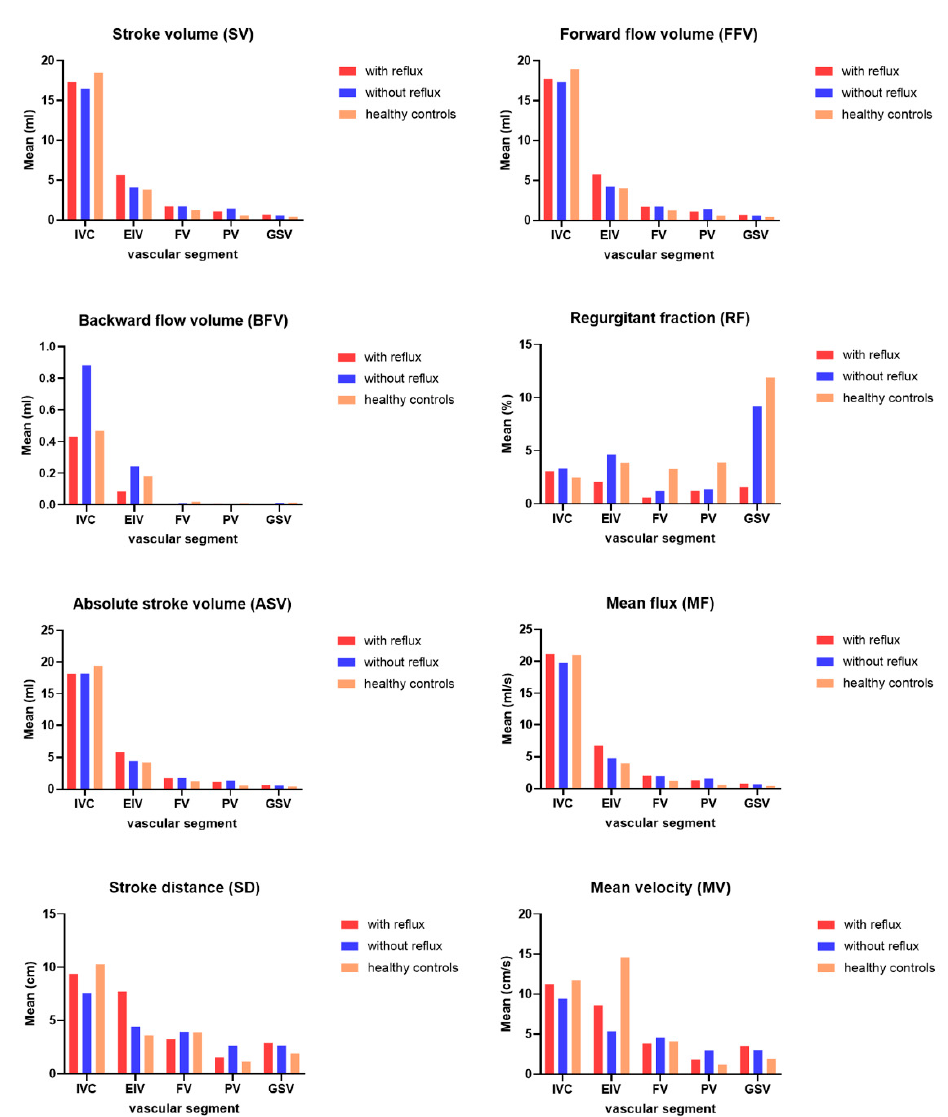
Figure 4. Barplots for each analyzed parameter. Each barplot presents means for each vascular segment grouped by studied group of subjects (with reflux, without reflux, and healthy controls). Table 4. The AUC analysis was performed to define the optimal cutoff values of SV, FFV, ASV, and MF because these QFlow parameters reached more significant differences between the reflux group and the HC group.